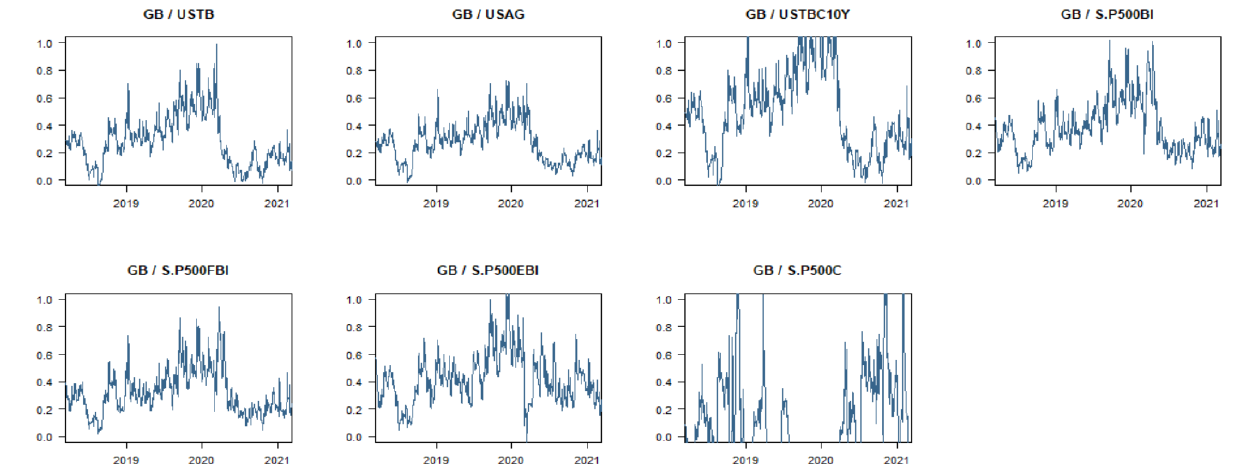
Figure 14. Dynamic hedge ratios (long/short).